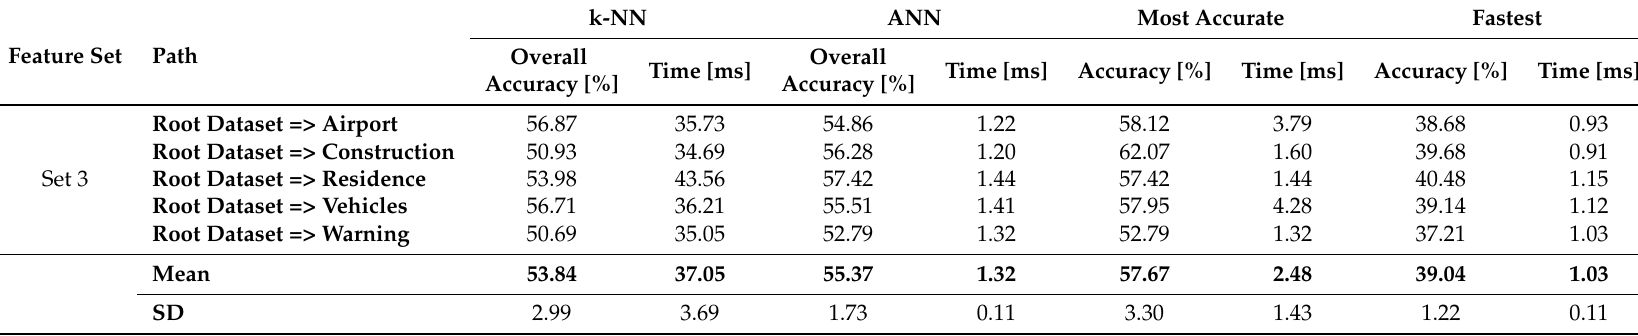
Table 11. Overall accuracy and timing in milliseconds of the cascade approach for the optimized k-NN and ANN classifiers. The average values are marked in bold.